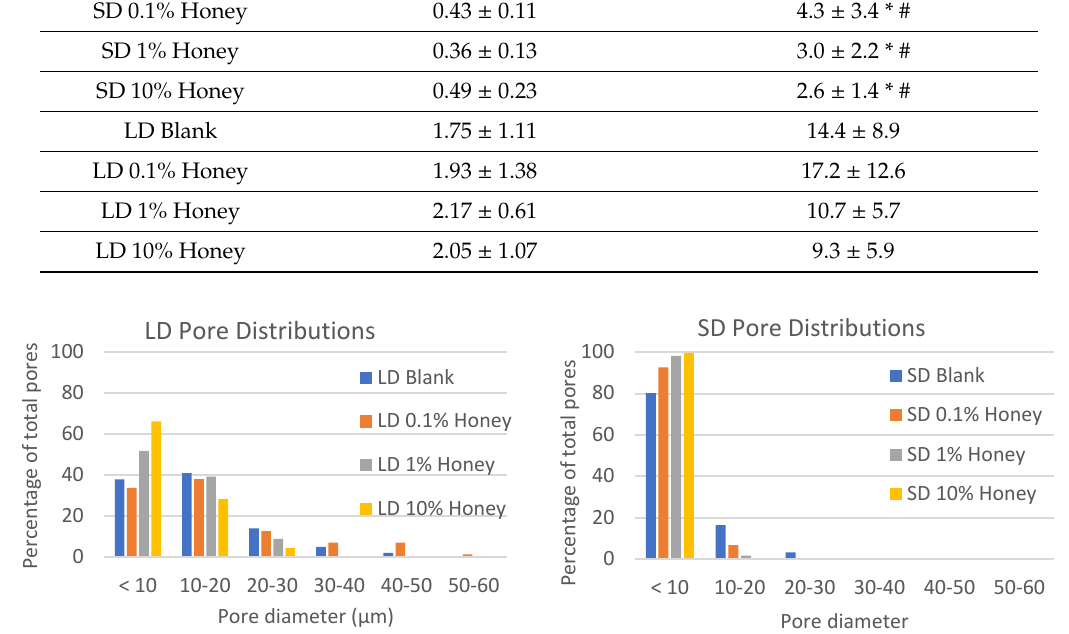
Figure 2. Honey reduces pore size. Histograms of pore distributions in LD and SD templates with 0%, 0.1%, 1%, and 10% honey.